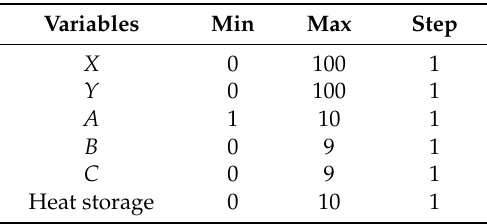
Table 4. Optimization variables.